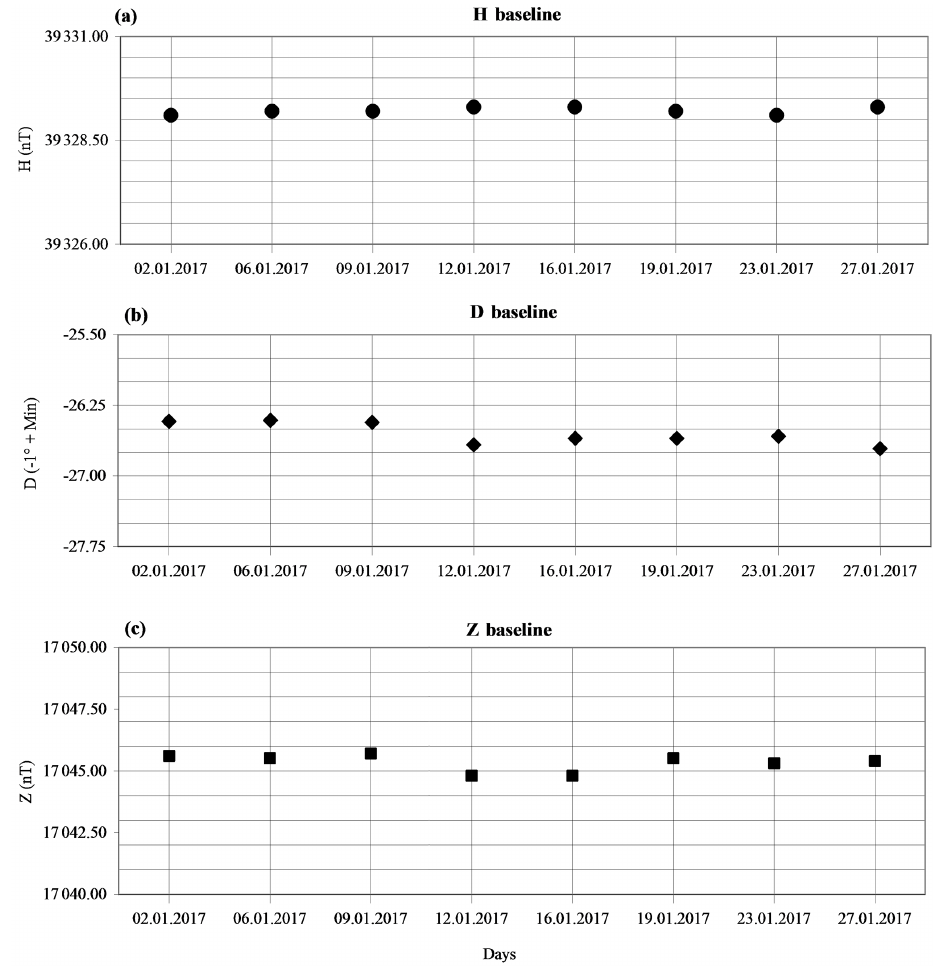
Figure 12. Baselines of January 2017 for